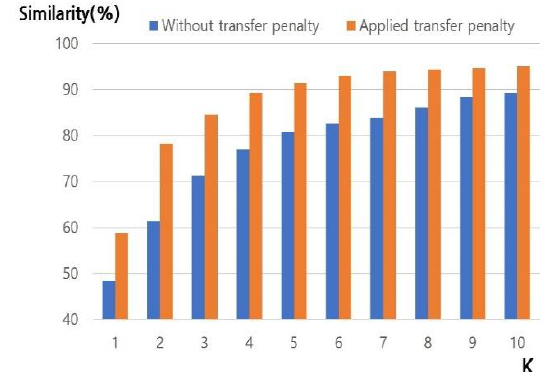
Figure 3. Visualization of the results of routing by improved RAPTOR algorithm